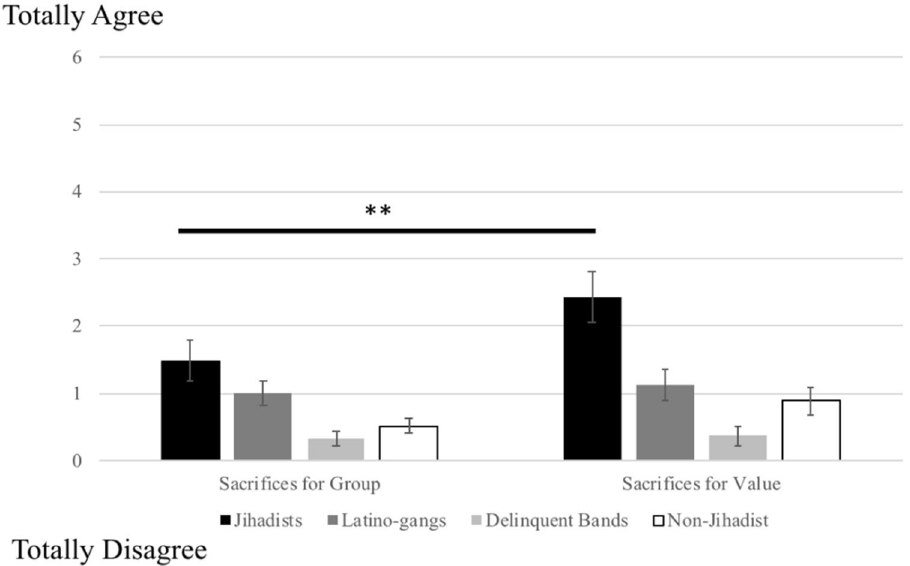
Figure 3. Sacrifice for group and for value. Jihadists are more willing to do costly sacrifices in prison for their more cherished group (Muslims) and value (Religion) than other criminals. And among jihadists, they are more willing to do costly sacrifices in prison for the value than for the group. ** p <